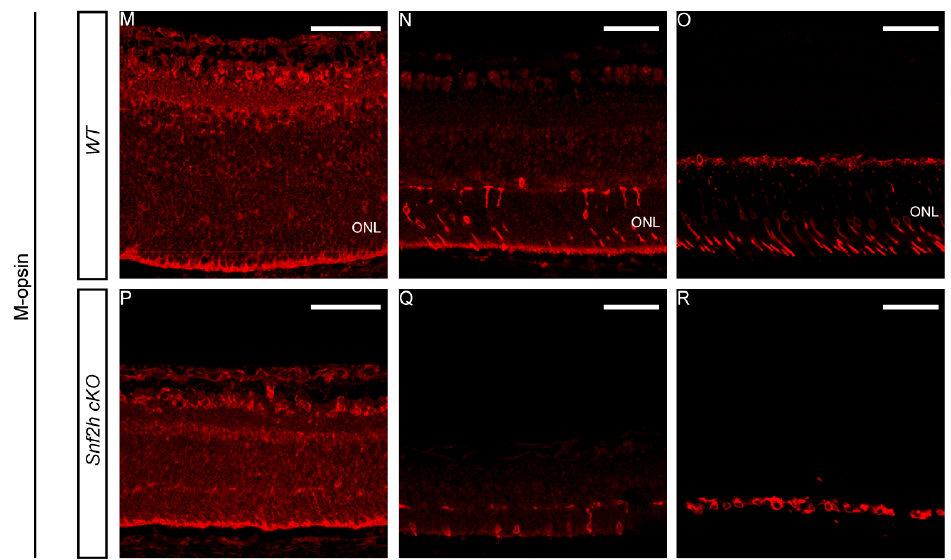
Figure 4. Photoreceptor maintenance in Snf2h cKO during postnatal stages. Specific opsin markers were used to determine the photoreceptor state in Snf2h cKO after birth. Rhodopsin detects the rod photoreceptors S-opsin (the short-wavelength cone photoreceptors) and M-opsin (the medium- wavelength cones). Except for M-opsin, which was not expressed until P8, opsin expression was mapped from P5 to P18 ( A – R ). At P10, all opsins were expressed in Snf2h -deficient retinae, although the ONL layer was significantly reduced in thickness compared with controls ( B , E , H , K , N , Q ). At P18, no rhodopsin-positive photoreceptors were present in Snf2h cKO, and only scattered rhodopsin- positive residues were identified in the entire retinal section ( F , indicated by an arrow). At P18, the differences between Snf2h cKO and controls in S-opsin ( I , L ) and M-opsin ( O , R ) expression were conspicuous, but not as pronounced as the loss of rhodopsin expression. Nevertheless, the shape of cone photoreceptors appeared abnormal. Scale bars: 50 µ